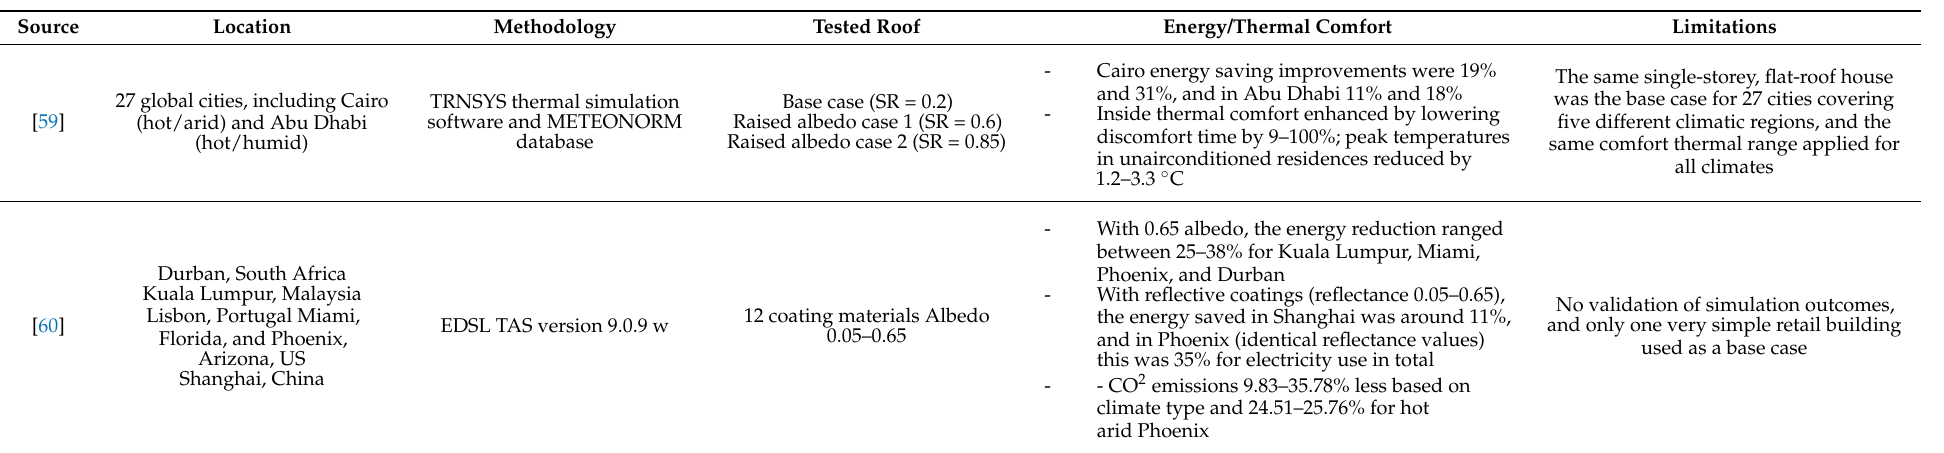
Table 2. Summary of the energy performance of cool roofs at the building scale in selected